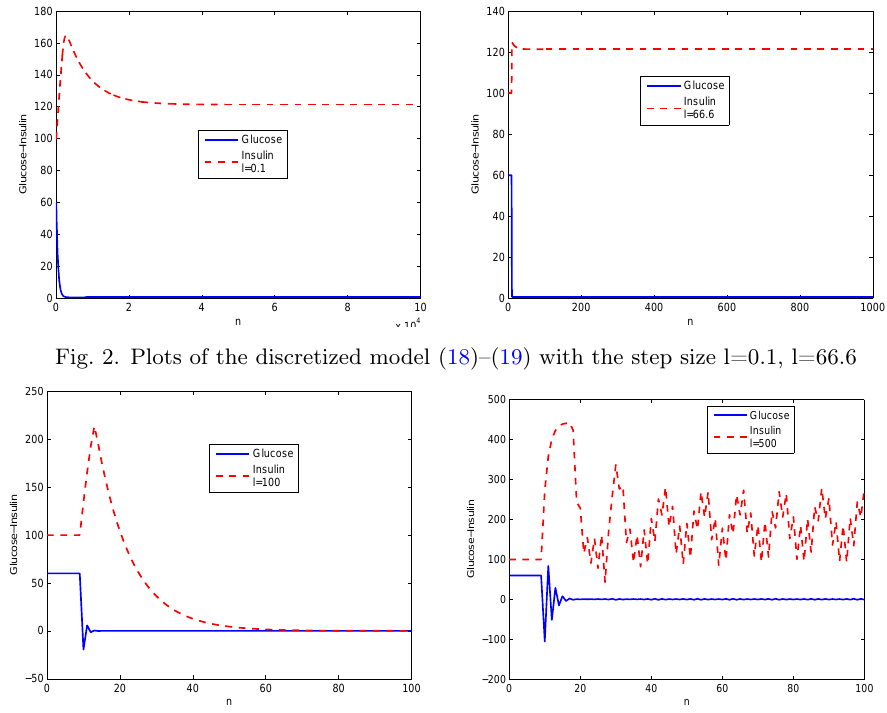
Fig. 3. Plots of the discretized model (18)–(19) with the step size l=100,